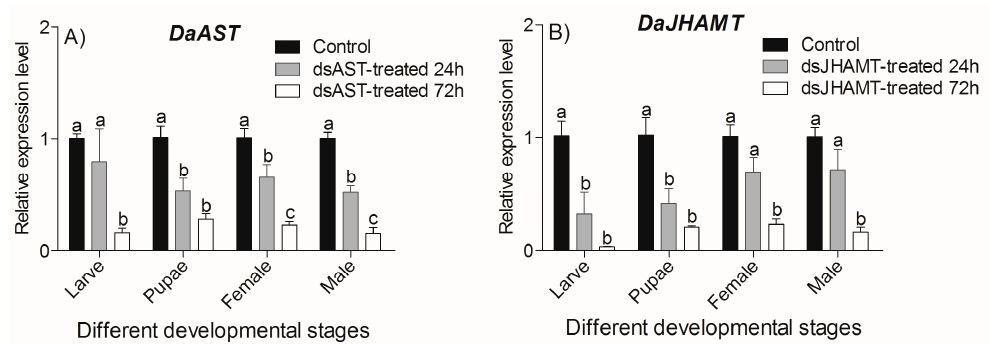
Figure 6. The qRT-PCR analysis of DaAST and DaJHAMT gene transcript patterns in D. armandi 24 and 72 h after dsRNA injection. ( A ) The qRT-PCR analysis of DaAST transcript pattern; ( B ) the qRT-PCR analysis of DaJHAMT . The standard errors of the means of three biological replicates are represented by error bars. Different letters above the bars indicate a significant difference (One-way ANOVA, p < 0.05, with Tukey’s test of multiple comparisons).